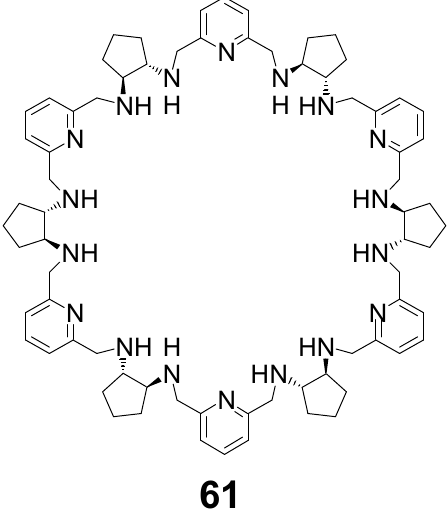
Figure 28. Molecular structures of the hexanuclear ( left ) and trinuclear ( right ) zinc(II) complexes of macrocycle 59 . Metal ions (violet) and the central chloride guest anion (green) are shown in spacefill representation, hydrogen atoms are omitted.